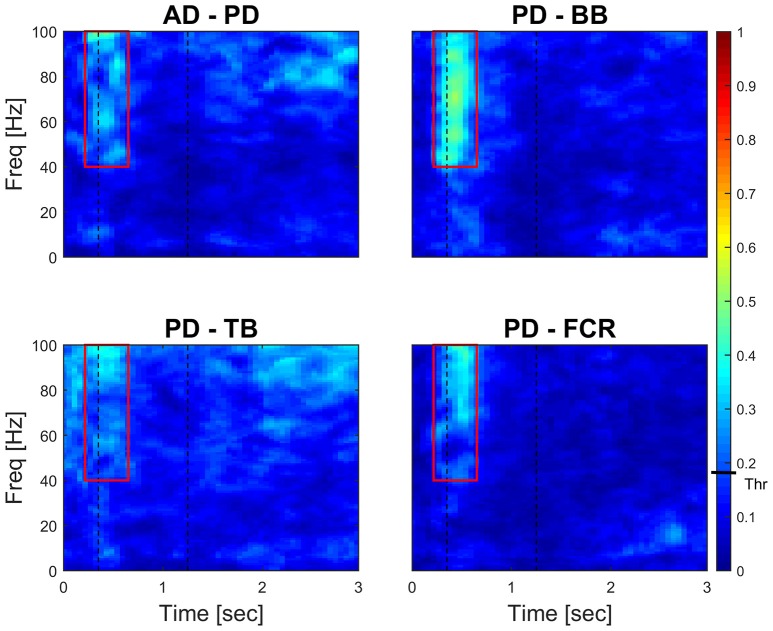
Time-frequency IMC during late adaptation (Block 12). Color-coded averaged (N = 16) IMC during late adaptation (Block 12) for the four out of twenty-one possible muscles pairs of the right arm that demonstrated significant IMC. An increase of coherence is shown in high-frequencies straddling the beginning of the movement. Dashed black vertical lines represent averaged movement onset and offset for Block 12. Continuous red lines represent window of interest straddling movement onset in the high-frequency range in which IMC absolute values are significantly different from 0. The confidence interval is represented by a black bar on color scale (Thr)–all colors above bar are significantly different from zero.